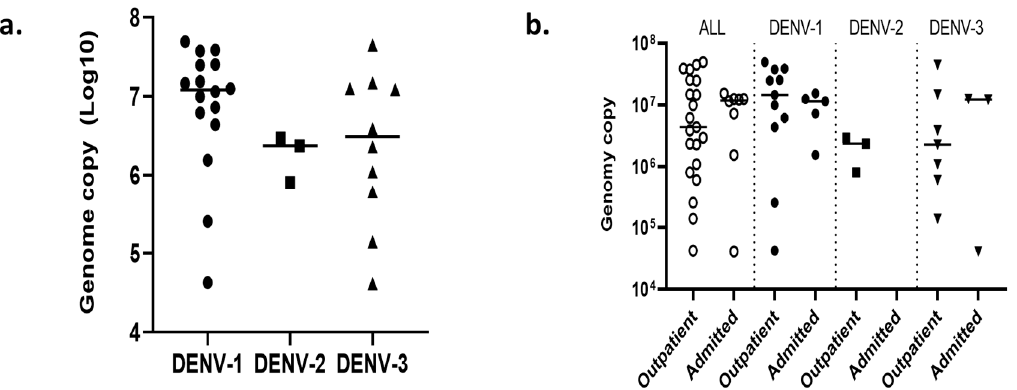
Figure 5. DENV viral load among different infecting serotypes and patient categories ( n = 29). ( a ) Dot-plot of log genome copy number in different DENV serotypes and ( b ) dot-plot of log genome copy number among outpatients and admitted patients (inpatients). The Mann–Whitney U test and Kruskal–Wallis test were used to compare two groups (outpatients and inpatients) and three groups (DENV-1, -2, and -3),